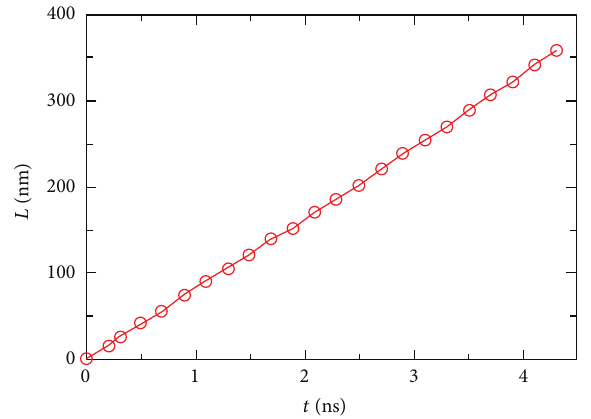
Figure 3: The distance 𝐿 travelled by the chloride ion ( 𝑀 = 35.5 Dalton), depending on the length of the simulation 𝑡 , at an external pressure of 𝑃 ≈ 500 atm and at temperature of 𝑇 = 300